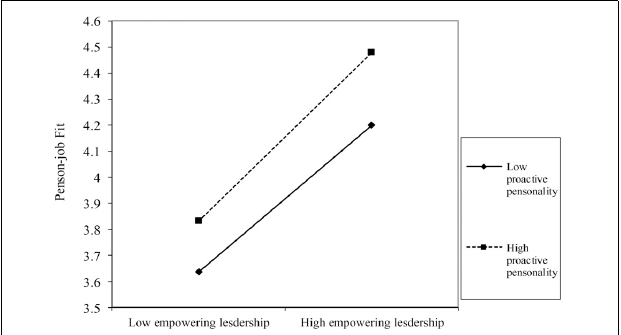
FIGURE 2 | Interactive Effect of empowering leadership and proactive personality on person-job fit.